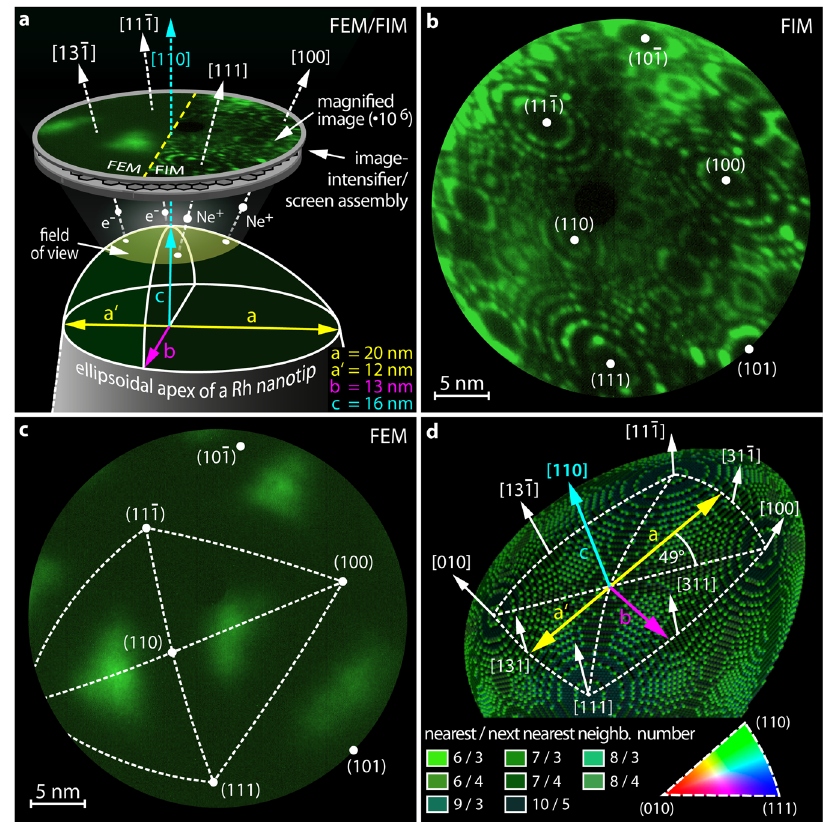
Fig. 1 | Apex of an ellipsoidal Rh nanocrystal. a Schematics of the experimental setup and the sample geometry: in FEM and FIM, fi eld emitted electrons and ions, respectively, form a point projection image of the sample surface. The apex of the [110]-orientedRhnanocrystalhasaxislengthsofa,a ′ ,bandc. b FIMimageoftheRh nanocrystal, obtained at T =77K using Ne + ions. c the same fi eldof view,but inthe